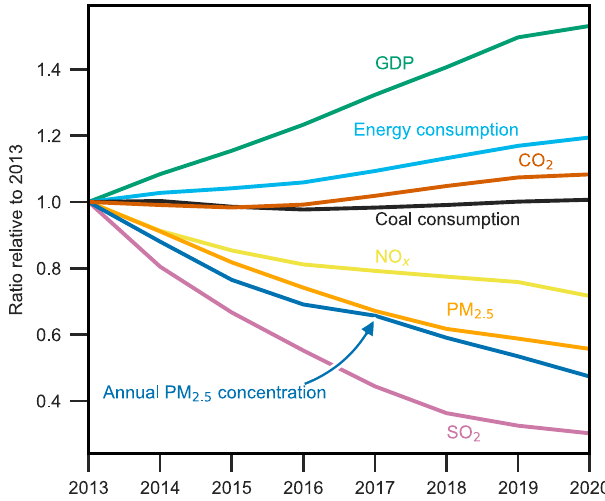
Fig.1|Trendsofanthropogenicemissions,annualPM 2.5 concentration,energy consumption and GDP in China between 2013 and 2020. The annual PM 2.5 concentration was calculated based on ground-based observations data in 74 key